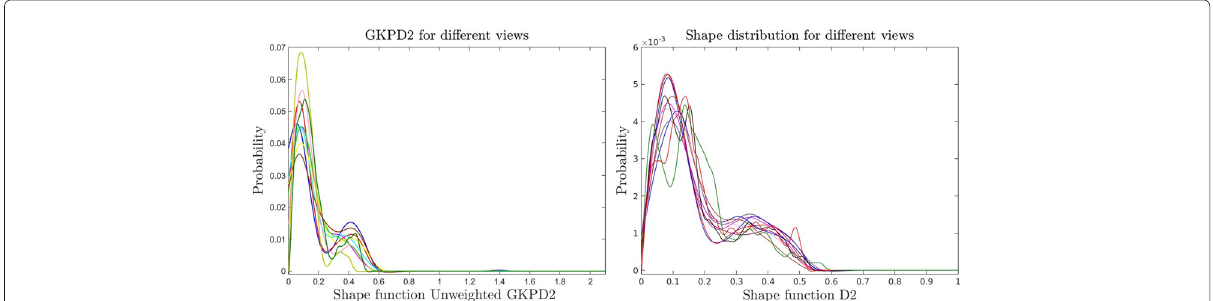
Fig. 18 Splines of Osada’s D2 shape distribution and GKPD2. Shape distributions and GKPDs of multiple views of a guitar (taken at 0°, 5°, 10°, 15°, 20°, 25°, 30°, 35°, 40°, 45°). It can be seen that GKPD2 is consistent across pose changes, whereas, D2 has changed its form with pose change of the